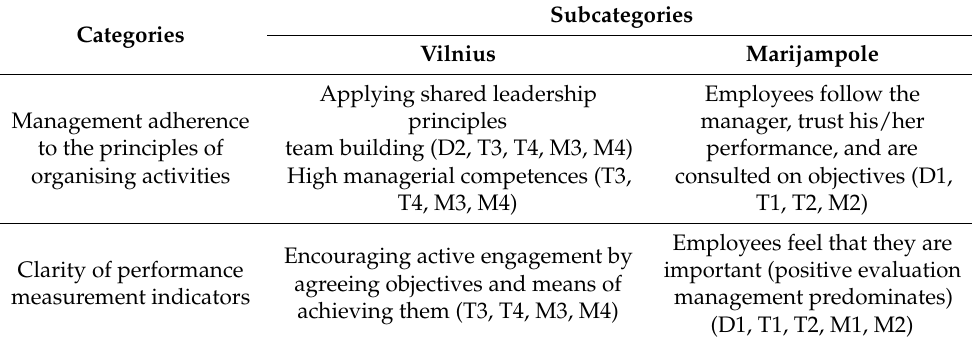
Table 5. Experiences of the manager-leader’s expression of matter